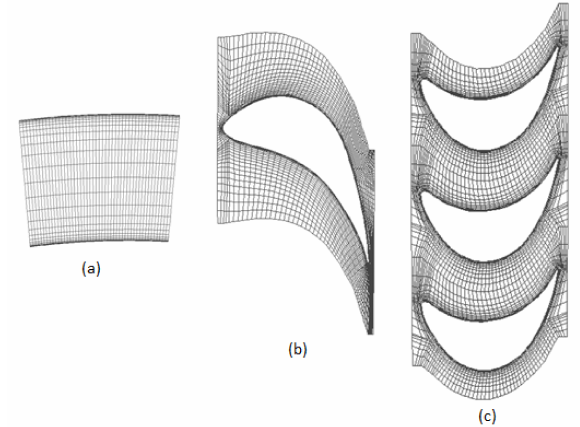
Figure 5. Mesh distribution for 1M cells. ( a ) radial distribution ( b ) stator vane distribution ( c ) rotor vane